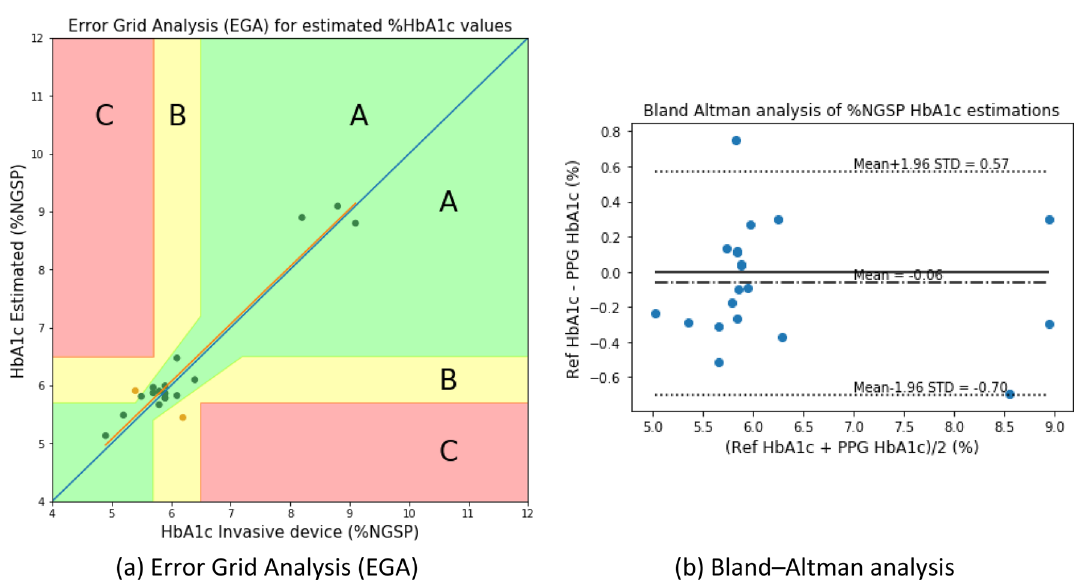
Figure 11. HbA1c Clarke’s error grid analysis (EGA) and Bland–Altman analysis for the whole-finger